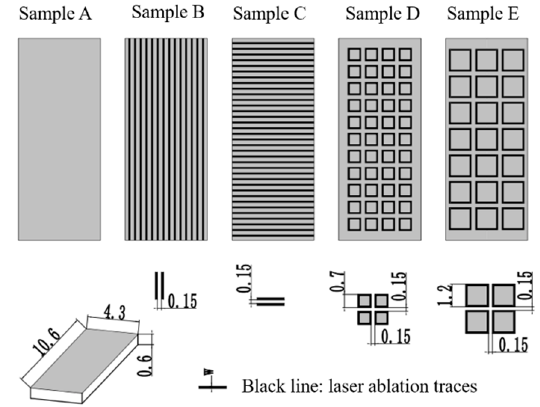
Figure 1. Schematic diagram of laser ablation traces. All samples have the same size of 10.6 × 4.3 × 0.6 mm 3 . Sample A was not ablated by laser. Samples B–D were ablated by laser but the ablation traces on these samples are different.